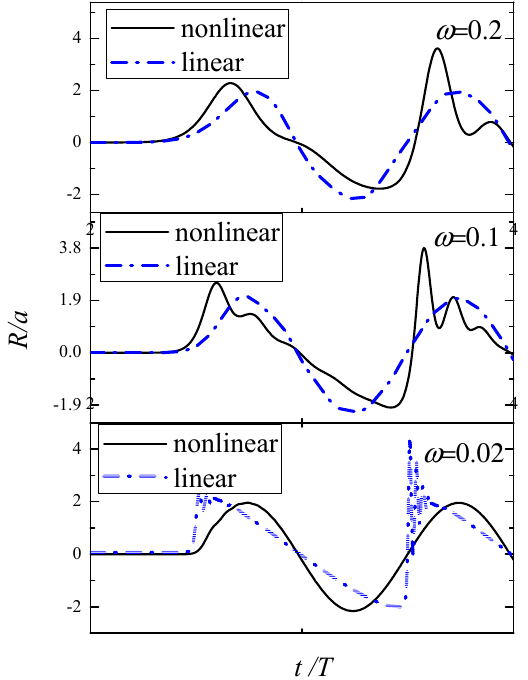
Figure 8. History of wave run-up along the vertical seawall for the case of double-crest wave train of different wave frequencies.